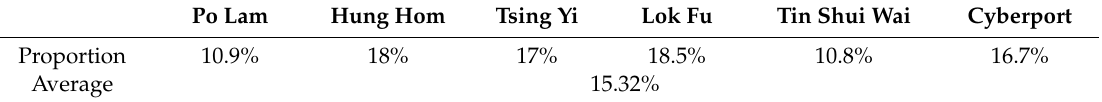
Table 1. Elderly population proportion in six regions and average proportion.